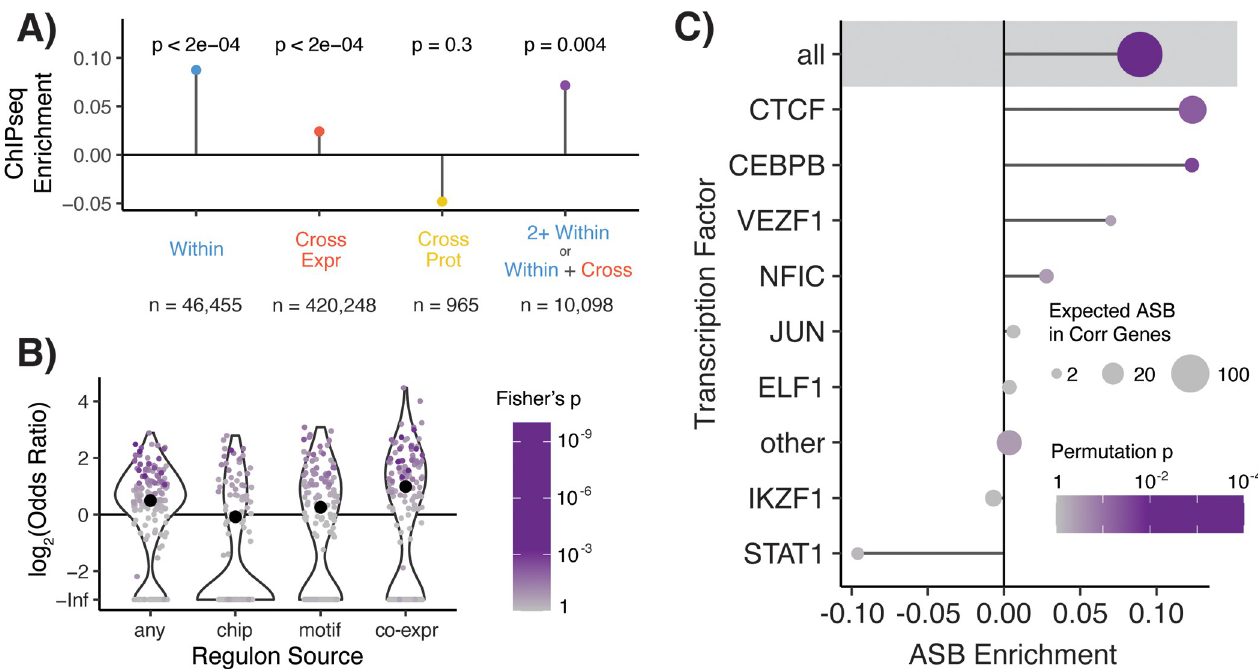
Fig 3. TF binding of TF-eQTL interactions. A) Overlap enrichment of TFBS, based on TF ChIP-seq peaks, of TF-eQTL interactions by dataset. Permutation- based p-values are plotted above each measurement. Datasets include within-tissue (blue) interactions, cross-tissue expression-based (red), cross-tissue protein- based (yellow), and TF-eQTL interactions with at least two lines of evidence from cross-tissue expression-based and within-tissue interactions (purple). B) The enrichment of target genes with two lines of evidence for TF-eQTL interactions falling into that TF’s regulon. Large black dots depict overall enrichment across TFs. C) Enrichment for allele-specific TF binding (ASB) for TF-eQTL interactions with two lines of evidence. Shaded area contains statistics for unmatched TF ASB analysis. Below that, statistics for matched TF ASB analysis is shown, with TFs with more than one expected ASB event plotted individually, and all other TFs combined